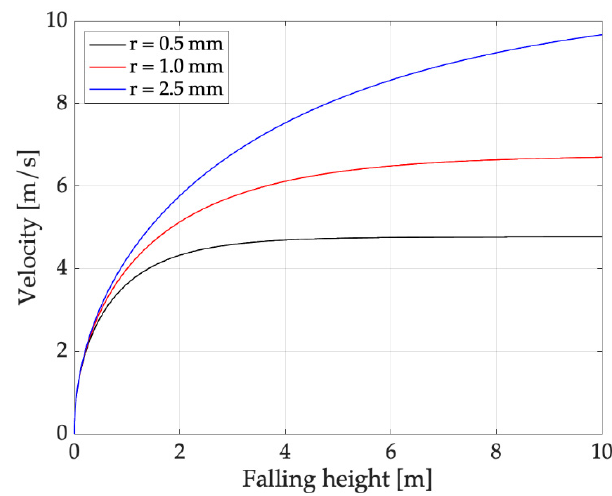
Figure 9. Raindrop velocity against falling height (the asymptotic value is the limit velocity).